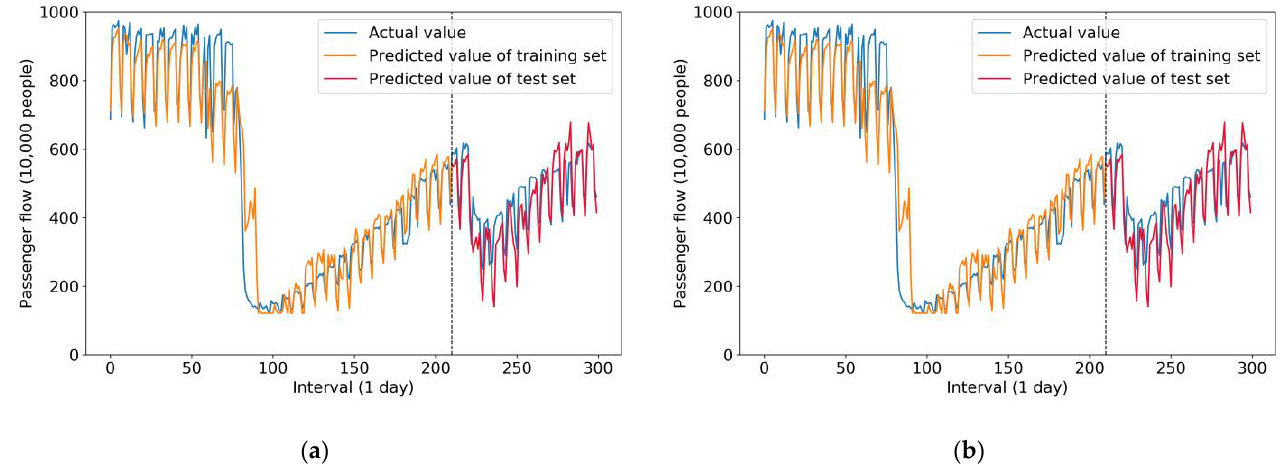
Figure 8. ( a ) Prediction curve of the LSTM model with features; ( b ) prediction curve of the GRU model with features.